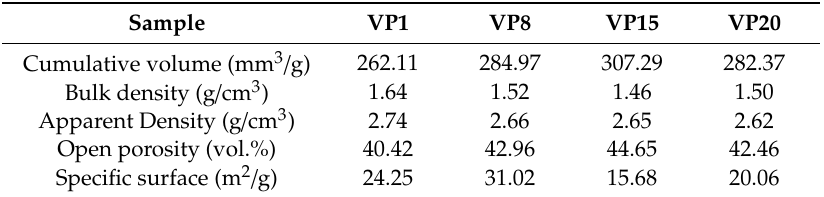
Table 7. Porosimetric features of Villa del Pezzolo